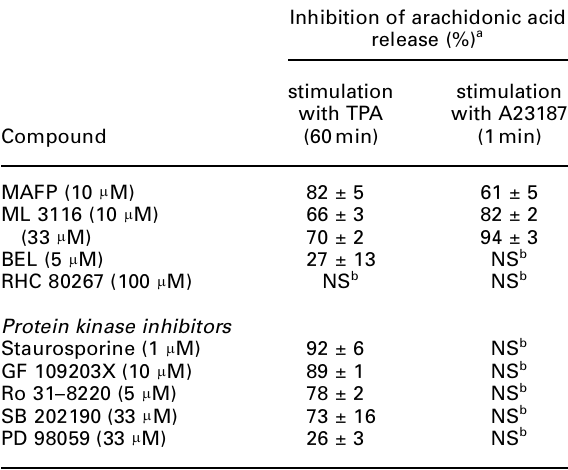
Table 1. Effect of the PLA 2 inhibitors MAFP, ML 3116 and BEL, the DAG lipase inhibitor RHC 80267 and different protein kinase inhibitors on the TPA- and A23187-induced release of arachidonic acid in bovine